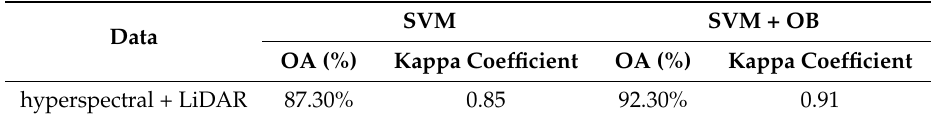
Table 2. Comparison of overall accuracy of SVM and SVM + OB (object-based) decision-fusion results using fused hyperspectral and LiDAR data. OA means overall accuracy.